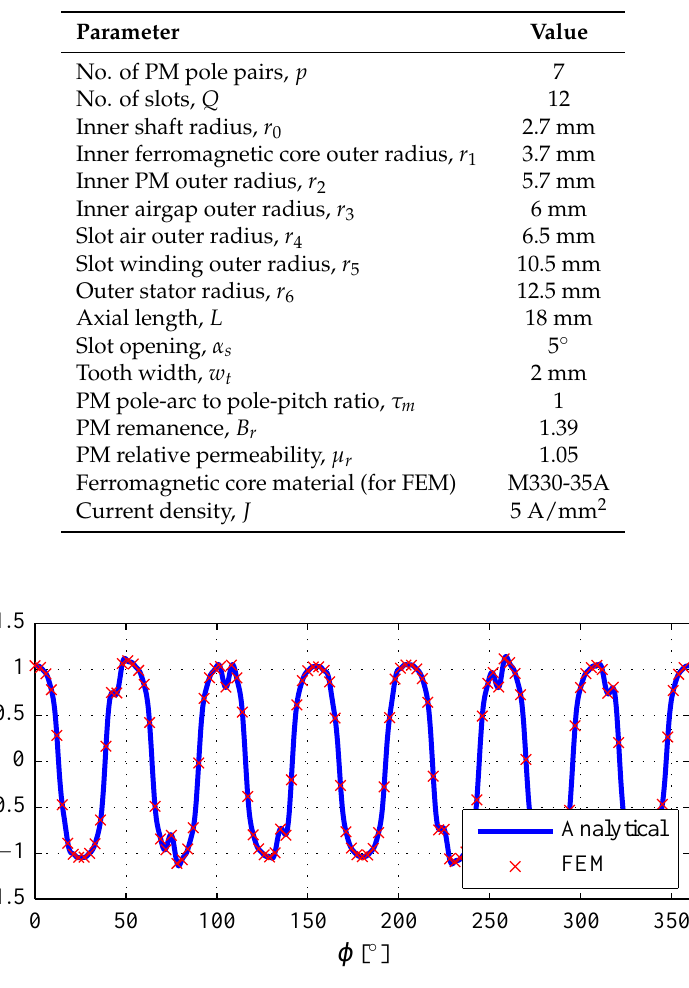
Table 2. Motor parameters for the model verification.